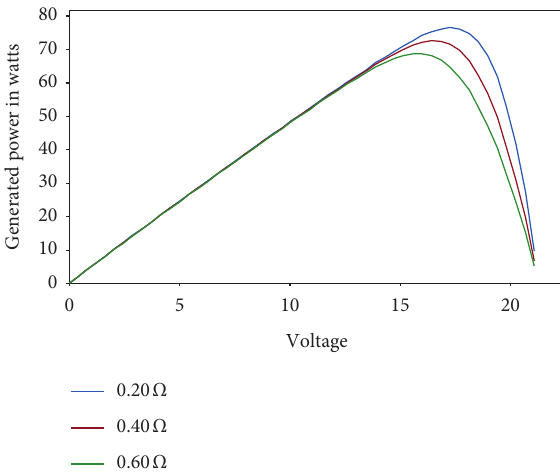
Figure 11: Simulated P-V plot of varying R